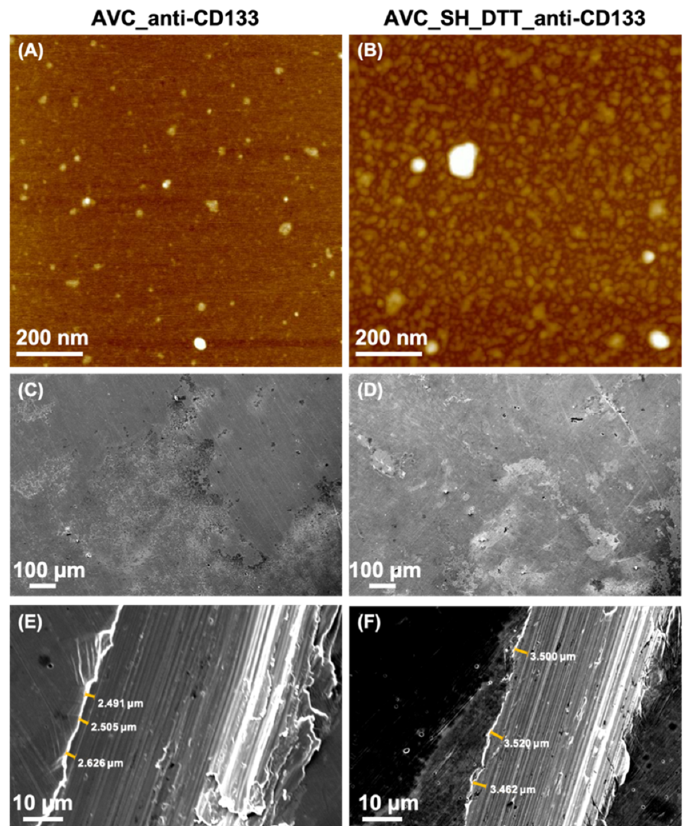
Figure 7. Atomic force microscopy (AFM) images of the AVC with deposited solution of anti-CD133 and AVC after mercaptosilanization, reduction and anti-CD133 immobilization ( A , B , respectively). SEM images of the biofunctionalized surfaces ( C – F ) with the thickness of the coating measurement marked ( E , F ).